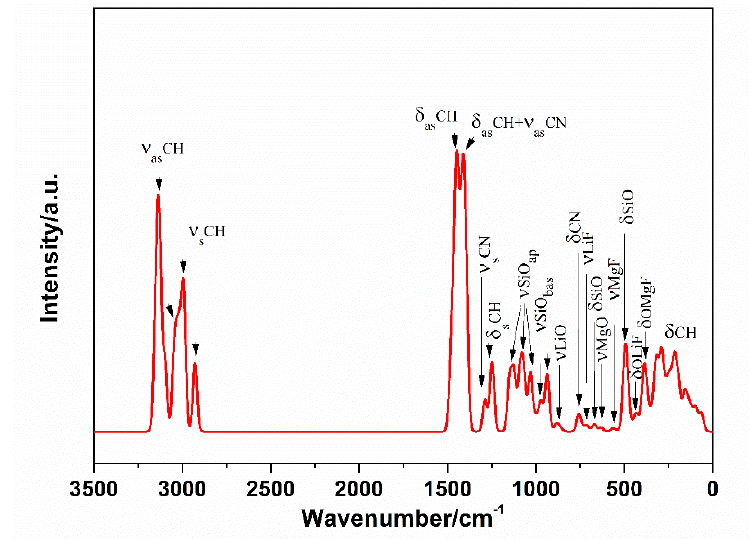
Figure 8. Calculated vibrational modes for the TMAH structure. Three main bands are present in the first region and one of them has a shoulder. asymmetric stretching vibrations, with a maximum at 3136 cm − 1 . The C-H symmetric 2995 cm − 1 (shoulder at 3034 cm − 1 ) and at 2927 cm − 1 .